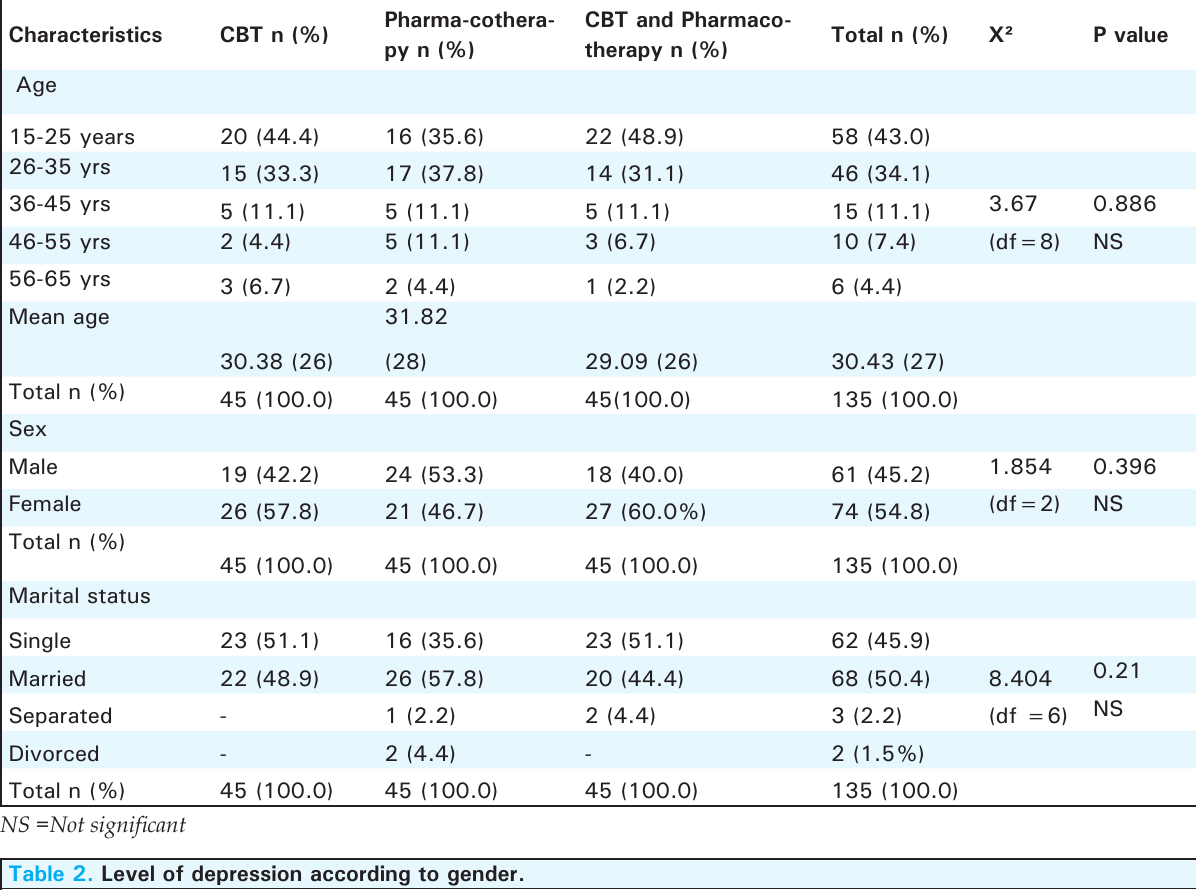
Table 1. Age, sex and marital status of patients among intervention groups. Characteristics